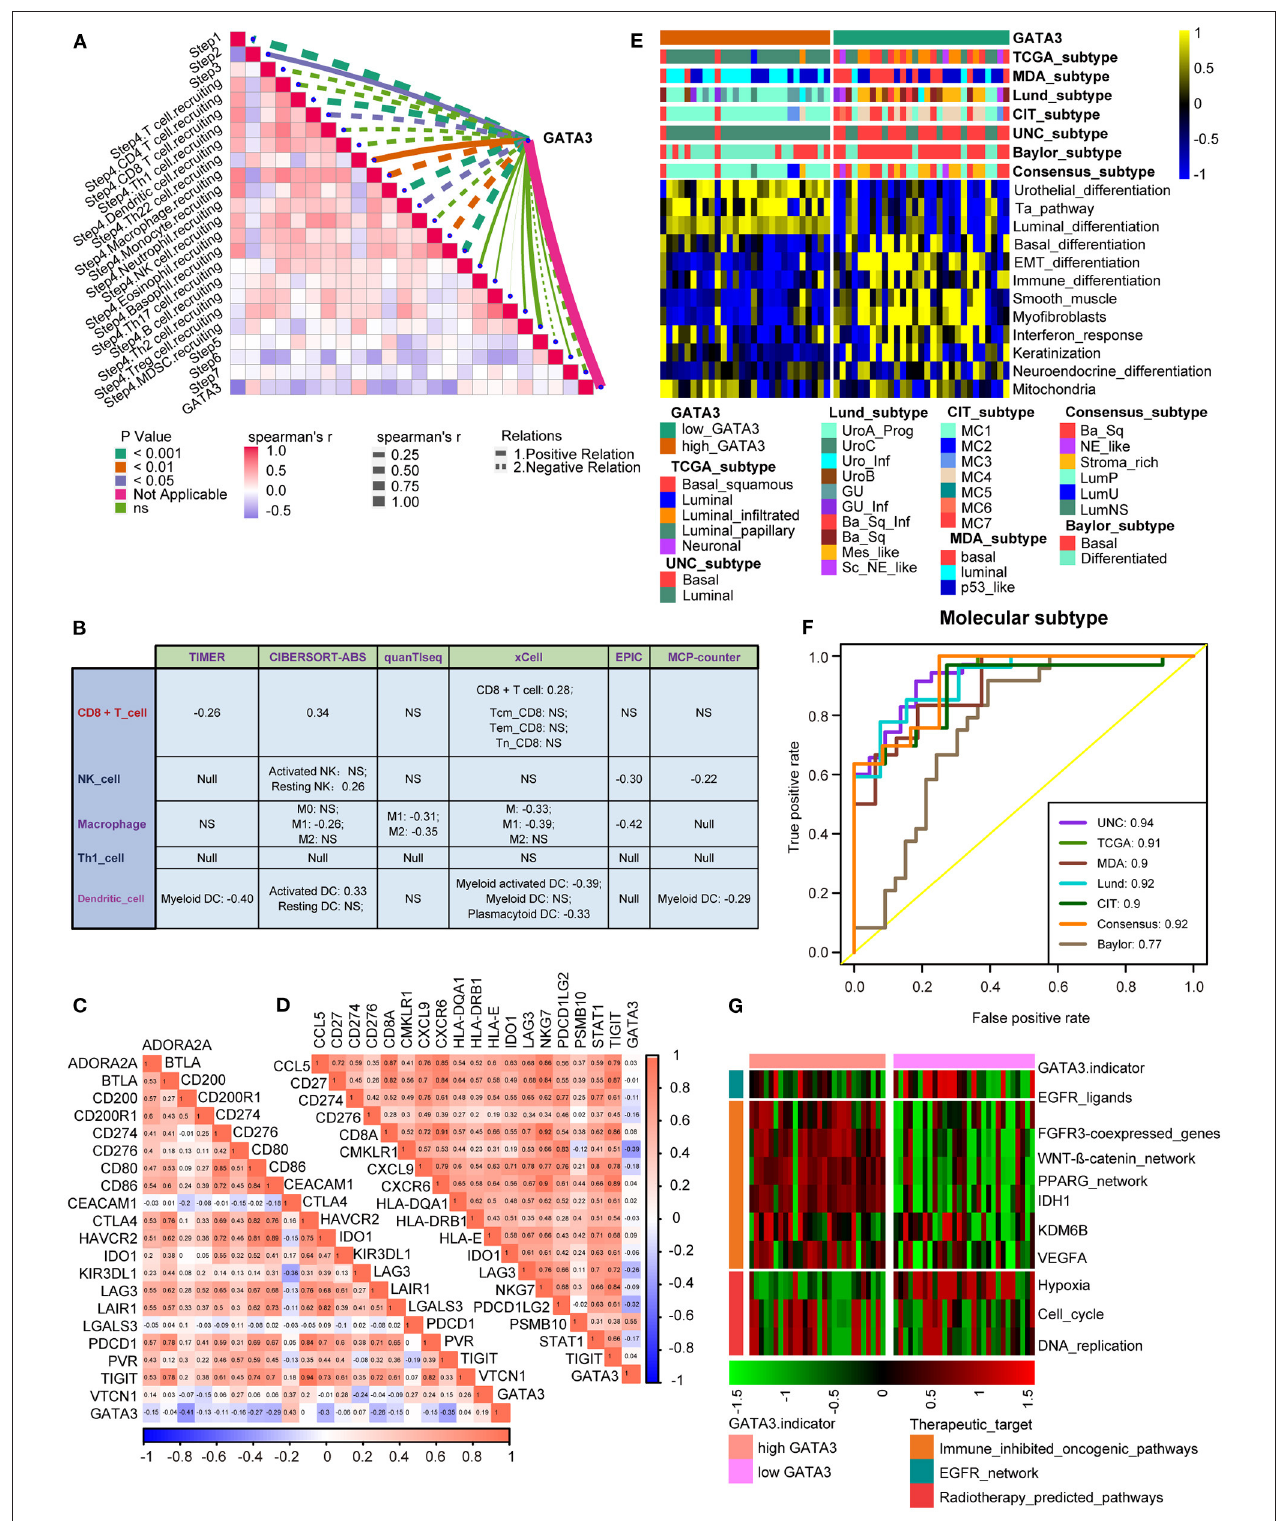
FIGURE 5 | Validation of the GATA3 prediction for molecular subtypes and the response to several therapies in the Xiangya-Pingkuang cohort. (A) Correlations between GATA3 and the process of the anti-cancer immunity cycle. (B) Correlations between GATA3 and the infiltration levels of five tumor-associated immune cells. (C) Correlations between GATA3 and 20 immune checkpoints. (D) Correlation between GATA3 and TIS-related effector genes. (E) Correlations between GATA3 and seven molecular subtype systems. (F) GATA3 molecular subtype prediction accuracy. (G) Correlation between GATA3 and the enrichment scores of therapeutic